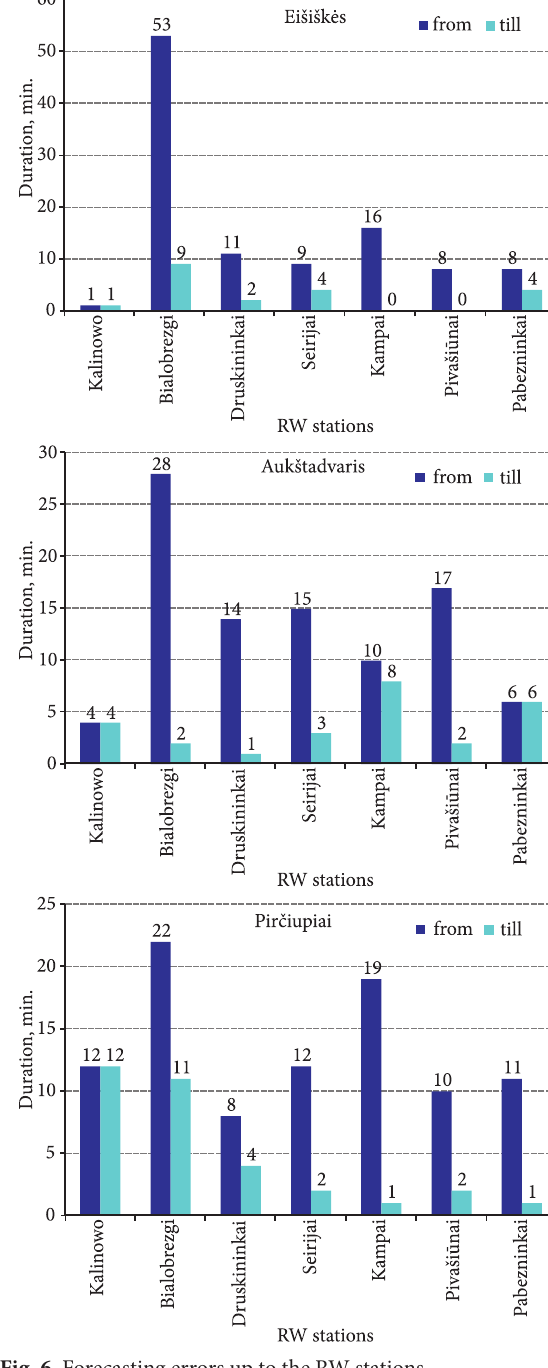
Fig. 5. Probability of precipitation in the final point Fig. 6. Forecasting errors up to the RW